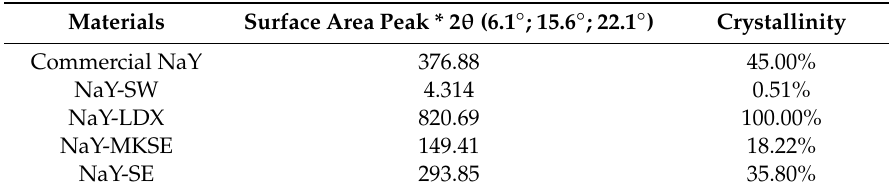
Table 3. The XRD surface area peak analyses of various NaY preparations.